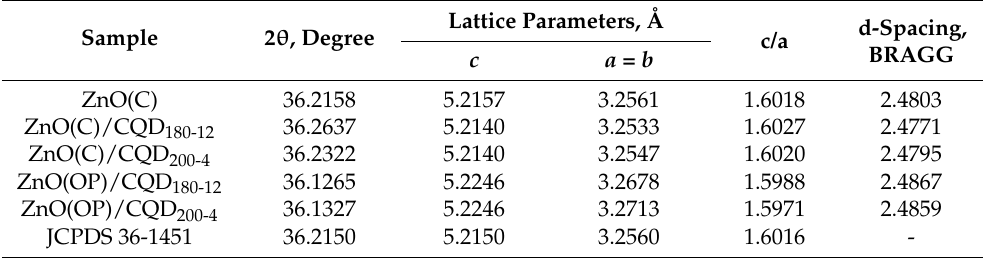
Table 2. The lattice parameters (a–c) and the inter-planer d-spacing of the ZnO/CQD samples.